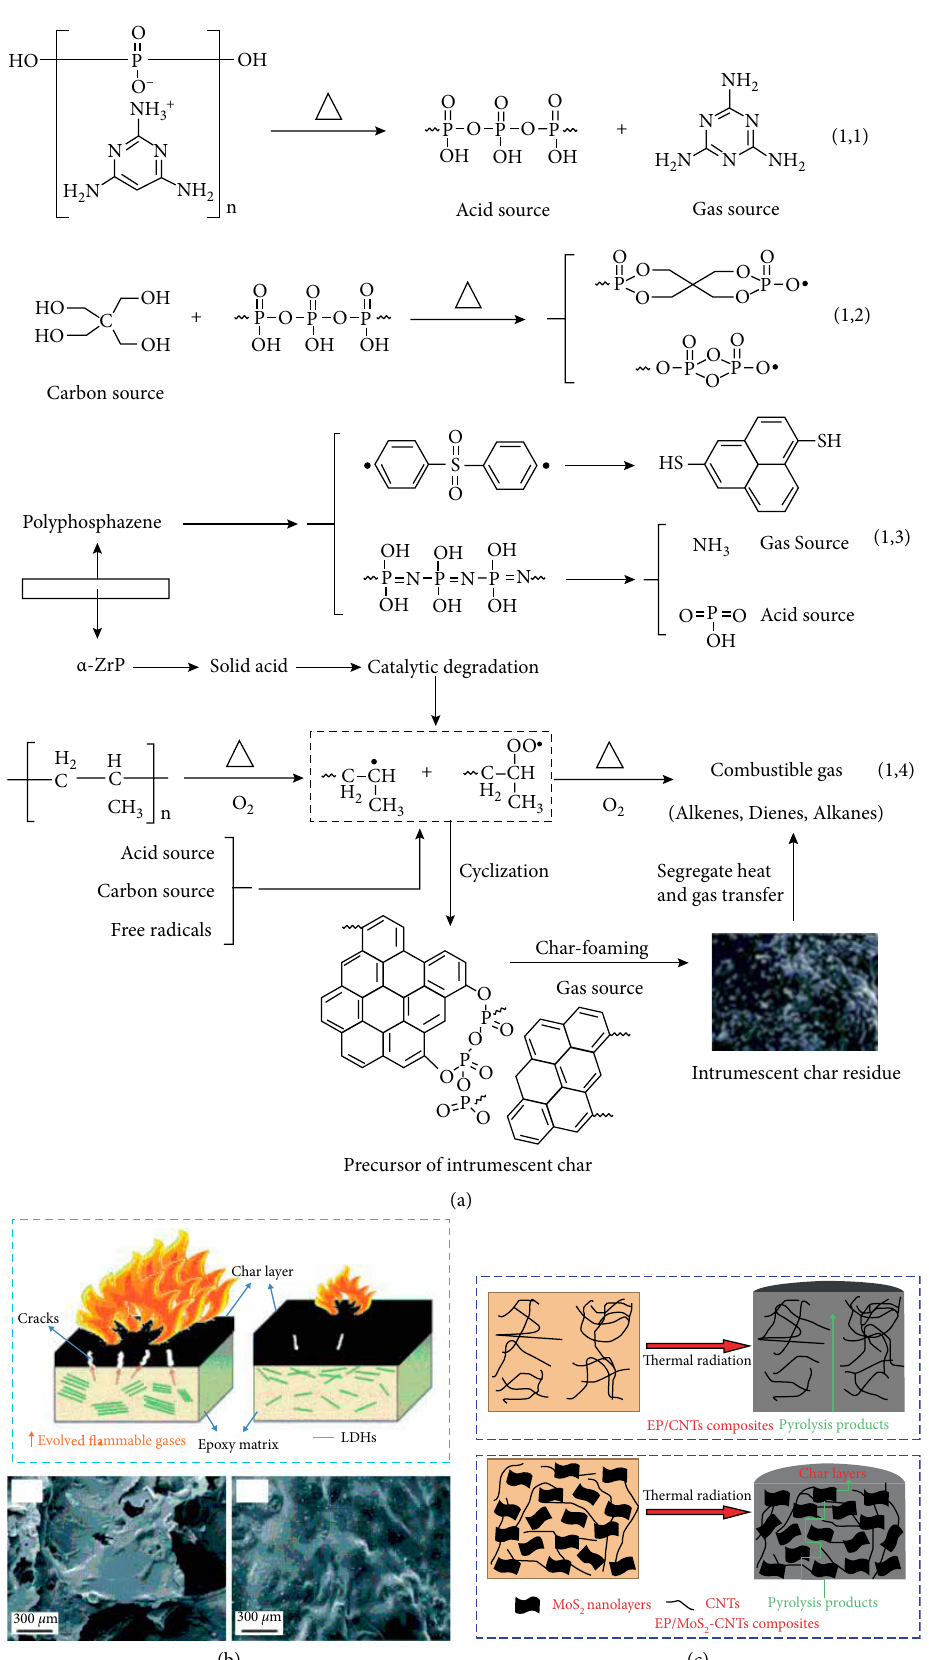
Figure 2: Flame retardant mechanisms of partial two-dimensional materials. (a) The free radicals of PP chain scission are inhibited, and then a coherent, thermally stable, and tough swollen char is formed under the catalysis of solid acid sites on the surface of a-zrp core [59]. (b) LDHs catalyze the formation of a thick char layer on the surface of EP [60]. (c) A MoS